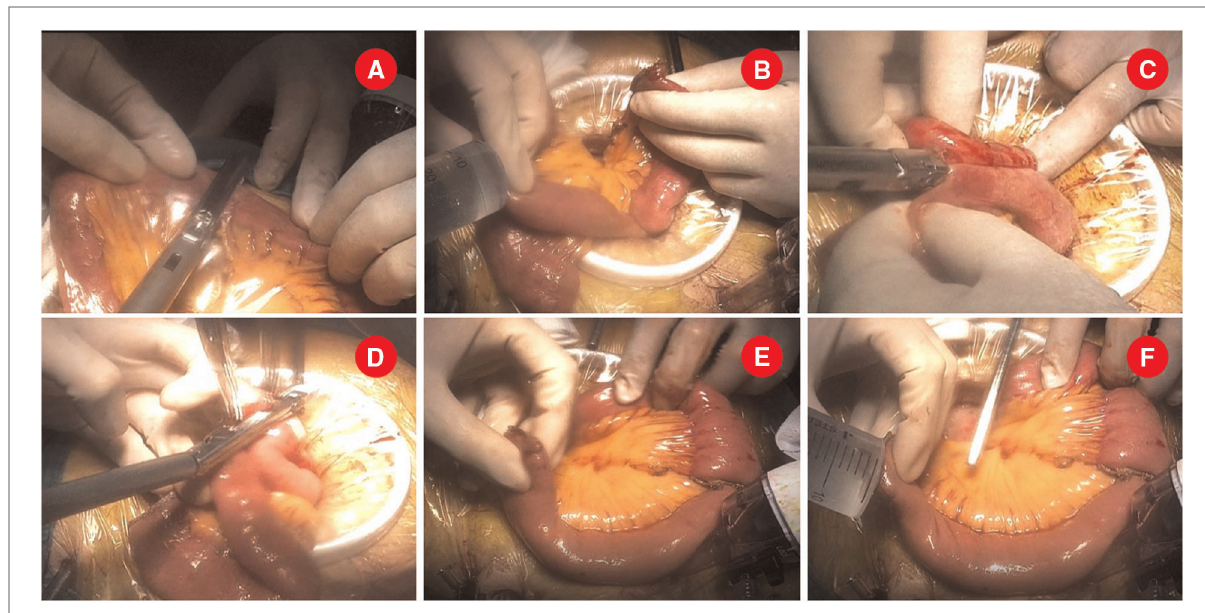
FIGURE 1 Jejunojenostomy was performed extracorporeally. ( A ). Jejunum was transected at 20 cm distal to the Treitz ligament. ( B ). Two small holes were made and an appropriate amount of saline was injected into each hole to facilitate the insertion of the stapler. ( C ). A 60 mm endoscopic linear stapler was separately inserted the above holes and created a side – side jejunojejunal anastomosis. ( D ). A 45 mm endoscopic linear stapler was used to close the common opening of enteroenterostomy. ( E ). A small opening was made at the stapling line of distal transected jejunum and a retracting suture was placed near the opening. ( F ). An appropriate amount of saline was injected into the